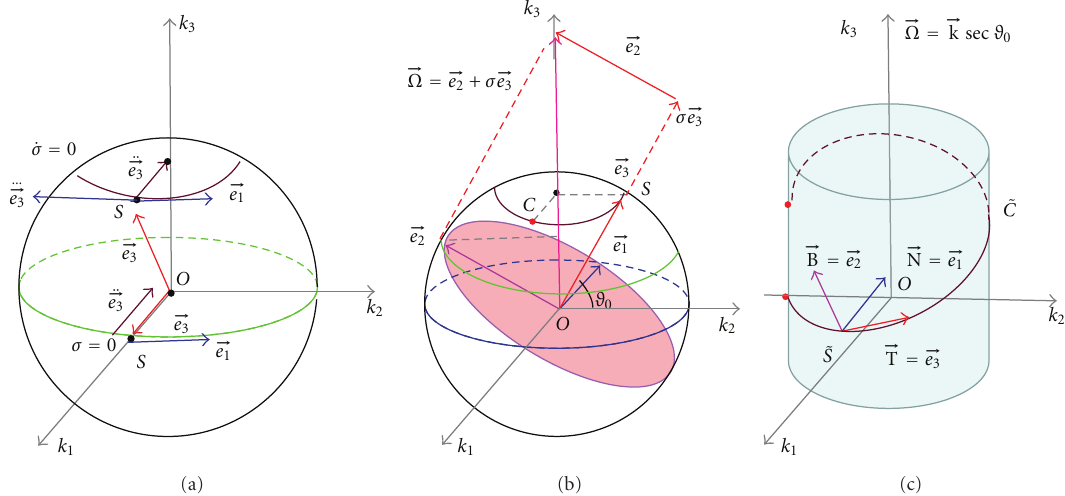
Figure 4: The circles on unit sphere and a helix in 3D space. (a) The illustration of σ = 0 and ˙ σ = 0, (b) a circular locus on the unit sphere and the motion of the frequency plane, and (c) the helix in 3D space and the motion of its TNB frame. The figure is not drawn to scale.